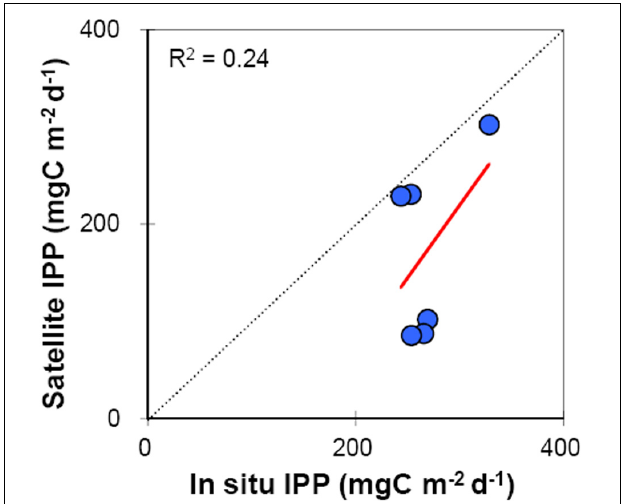
FIGURE 6 | Linear relationship between in situ and satellite-derived primary productivity measurements ( r 2 = 0.24, n = 6, p > 0.05). The dotted line indicates 1:1 relationship. Data points close to (away from) the 1:1 line belong to RT (TS) stations,